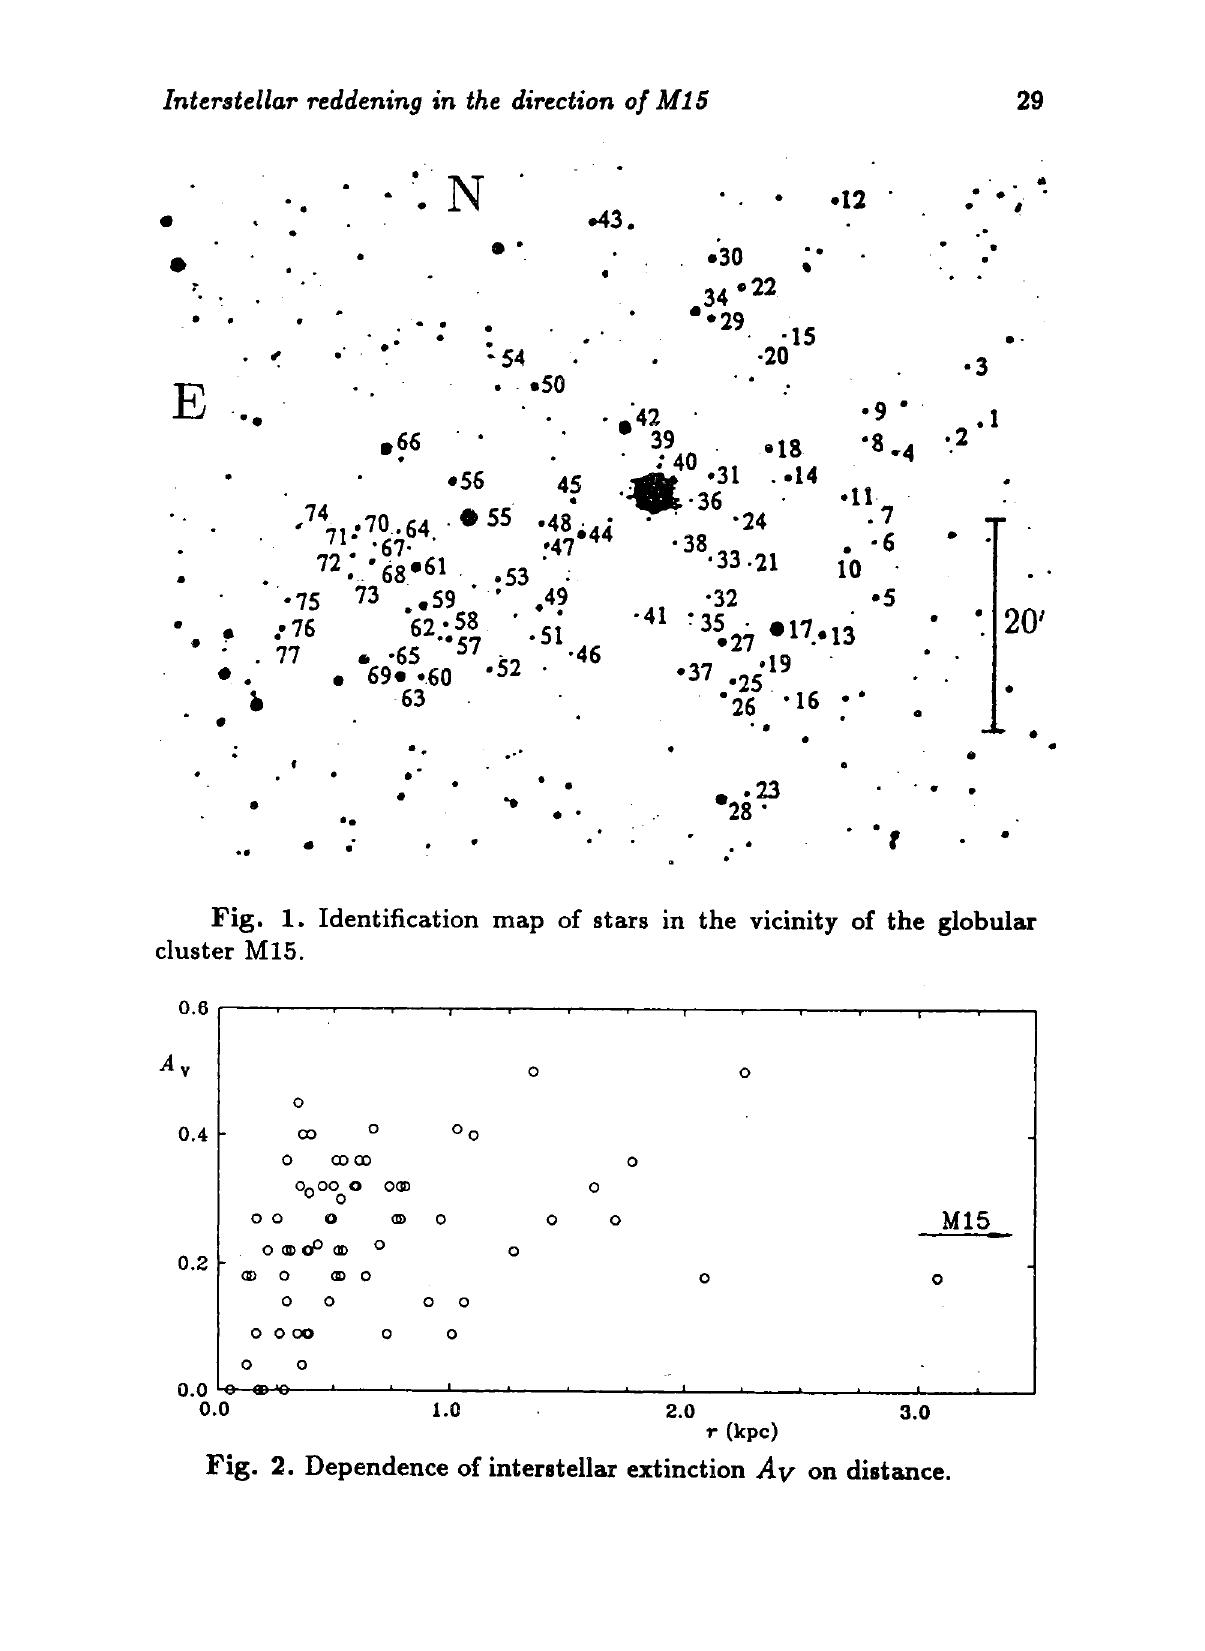
Fig. 2. Dependence of interstellar extinction Ay on